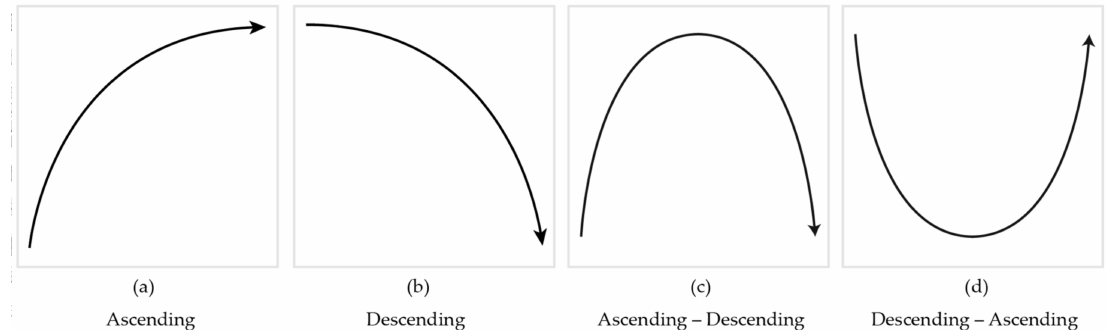
Figure 1. The contours of auditory stimuli.